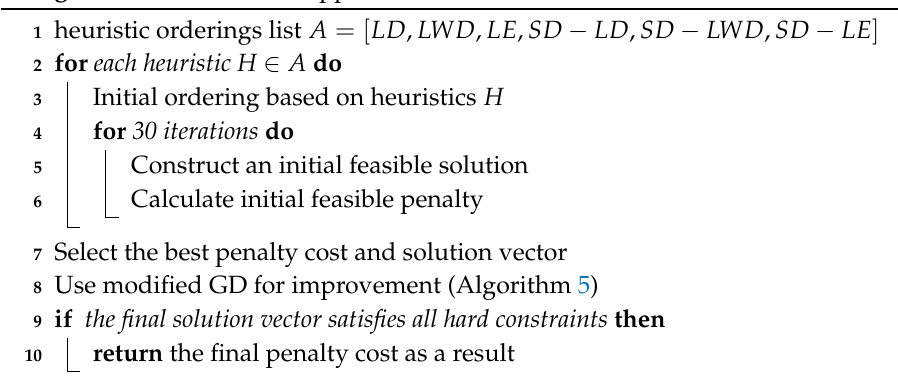
Algorithm 6: TGH-mGD